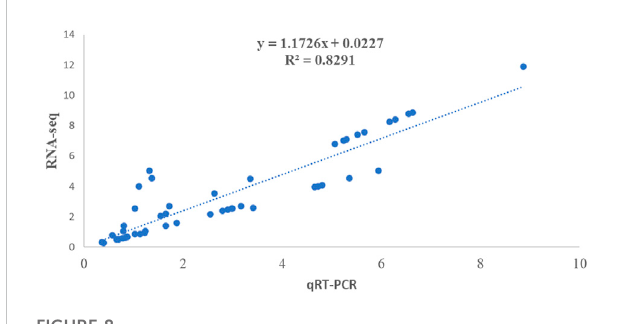
FIGURE 8 Validation of expression results using qRT-PCR representing the correlation between qRT-PCR and RNA-seq expression results for 20 selected DEGs from leaf and root tissues samples of V . mengtzeanum